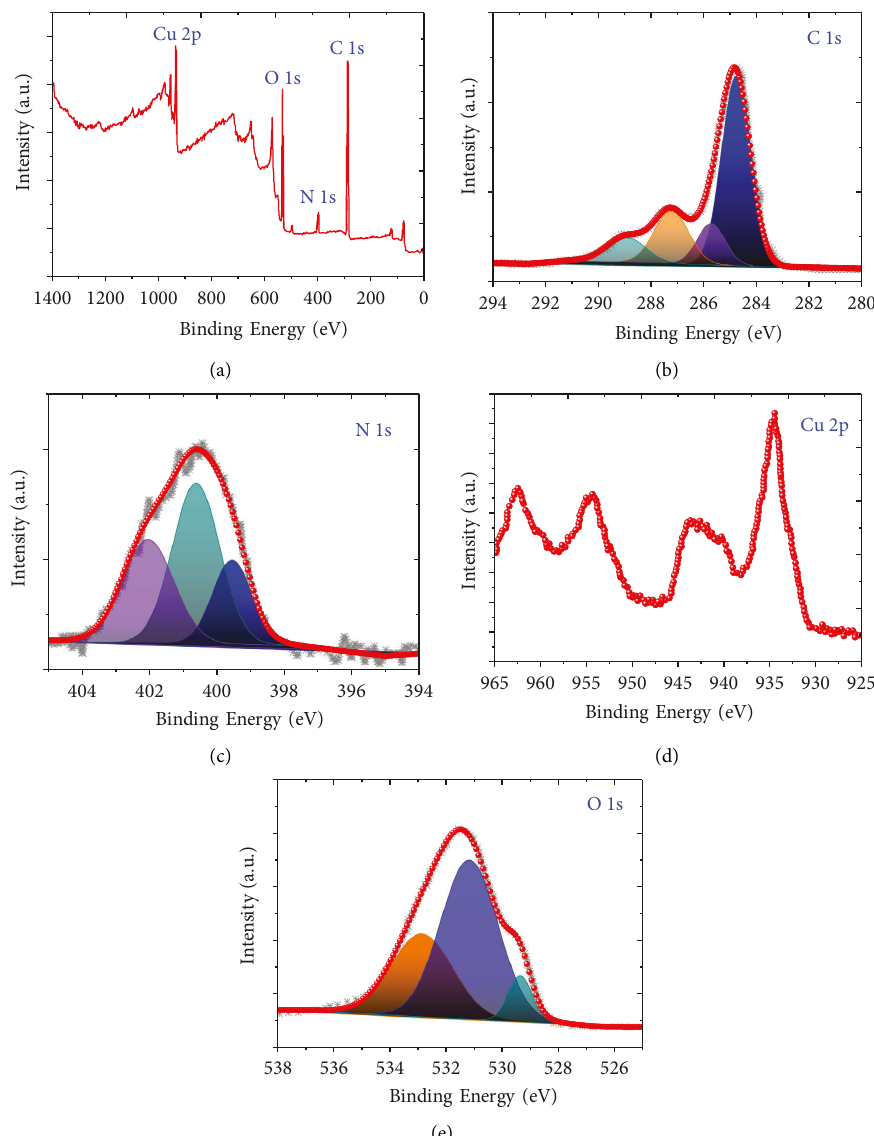
Figure 3: XPS spectra of CuO@NDC: (a) Survey scan, (b) C 1s spectra, (c) N 1s spectra, (d) Cu 2p spectra, and (e) O 1s